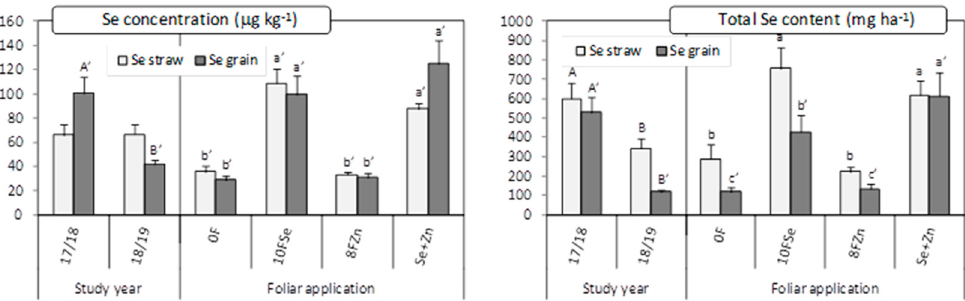
Figure 3. Concentration of Se and total Se content in the straw and grain as affected by the main effects ‘Study year (Y)’ and ‘Foliar application (F)’. Charts indicate means (for straw n = 3; for grain n = 4) and error bars indicate standard error. Within each factor and plant part, different letters mean significant differences between means according to LSD test ( p ≤ 0.05). To make the differences clearer, a different set of letters was assigned to each factor and plant part (lowercase letters for ‘F’, uppercase letters for ‘Y’). Letters follow by apostrophe (‘) for grain. Although the LSD test was performed on the transformed variable, back-transformed values are represented to ease interpretation. Table 2. Molar ratio phytate: mineral (Zn and Se) in the straw and grain, expressed as mean value ± standard error ( n = 3 for straw and n = 4 for grain) as affected by the main effects ‘Study year (Y)’, ‘Foliar application (F)’ (in bold) and by their interaction ‘Y*F’.